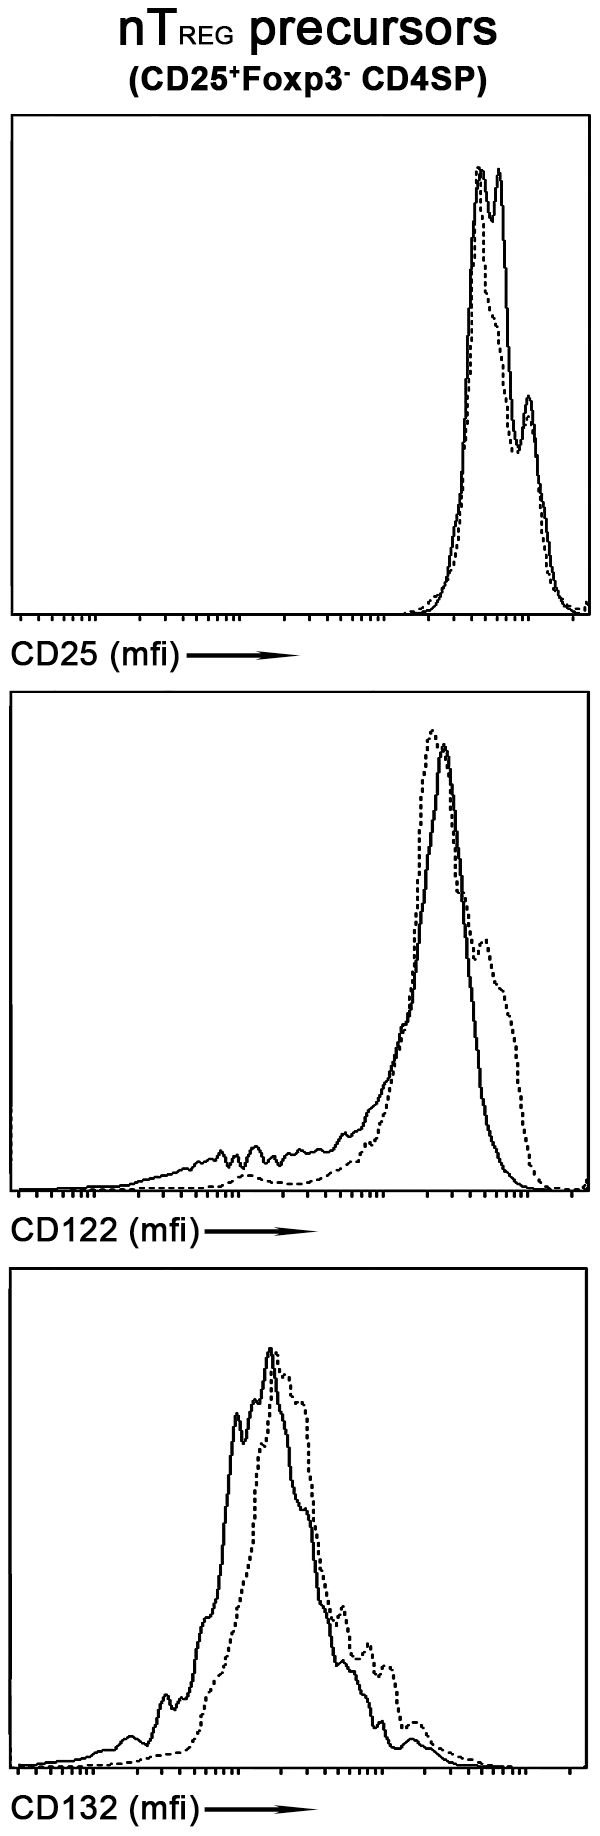
IL-2 receptor expression on nTreg precursors.Total thymocytes isolated from foxp3gfp and c-rel−/−foxp3gfp mice were pre-enriched for CD4 SP cells using a CD8 depletion strategy described in Methods, then stained with antibodies for CD4, GITR, CD25, CD122 and CD132. Histograms show expression levels (mean fluorescence intensity or mfi) of the CD25, CD122 and CD132 chains of the IL-2 receptor on wt (solid line) and c-rel−/− (broken line) nTreg precursors (GITRhiFoxp3−CD4SP cells). The data shown is representative of three independent experiments in which 3 mice of each genotype were used in each experiment.